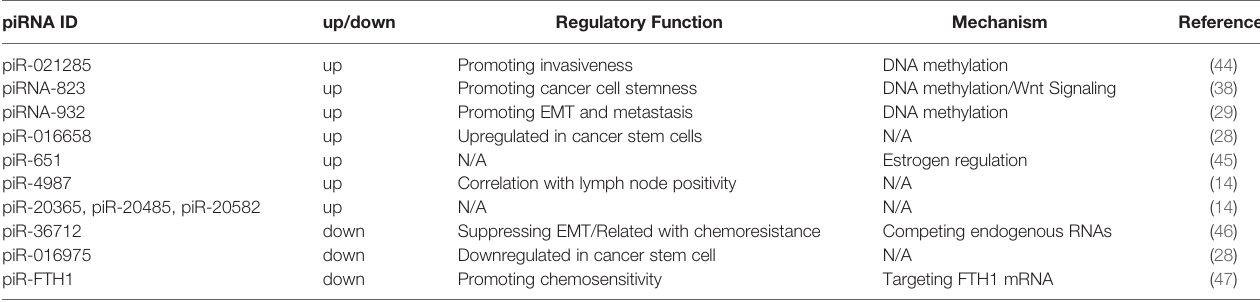
TABLE 1 | Deregulated piRNAs in human breast